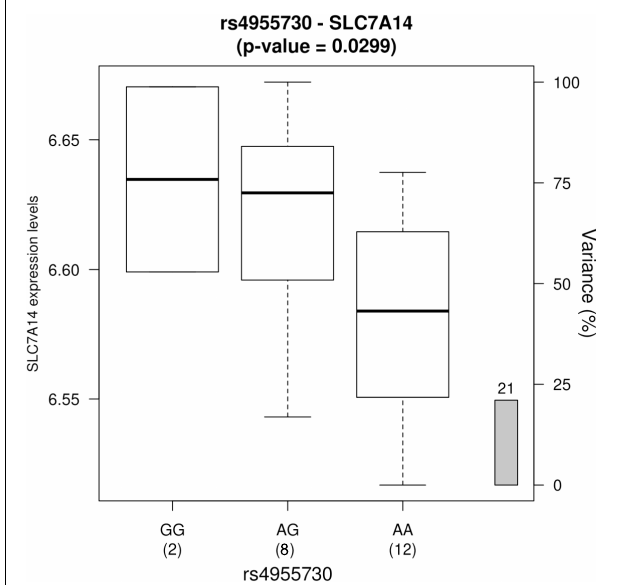
FIGURE 5 | Gene expression levels of the SLC7A14 gene in human aortic valves according to 3 genotype groups for the SNP rs4955730 ( n = 22, p = 0.0299). The left y -axis represents gene expression levels in the aortic valves. The x -axis represents the three-genotype groups for the SNP rs4955730 with the number of subjects in parenthesis. The right y -axis represents the percent variance ( r 2 ) in expression levels explained by the genotype for this SNP. The G allele, that seems to have a protective effect for SaIE, is associated with a higher level of gene